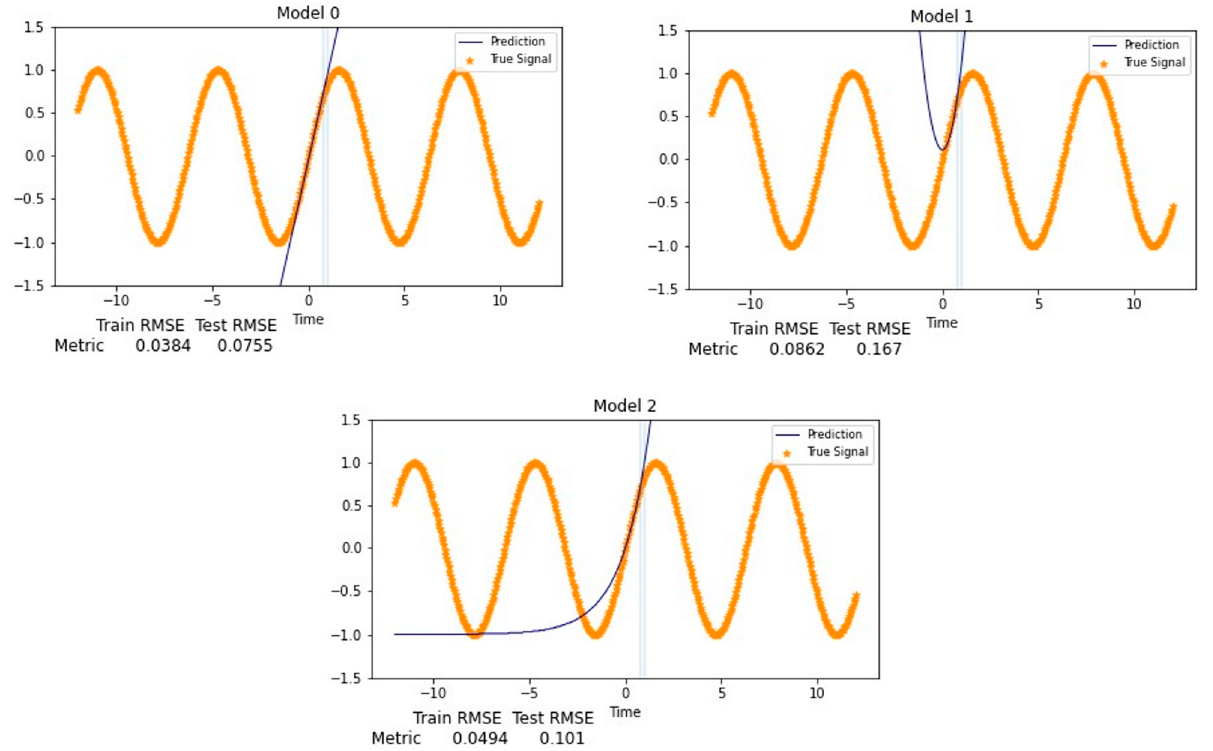
Figure 3. Analysis of the true signal modeled in Figure 2. When the models generalized on the data, all performed poorly, as there was not enough information provided during training to generalize shape.